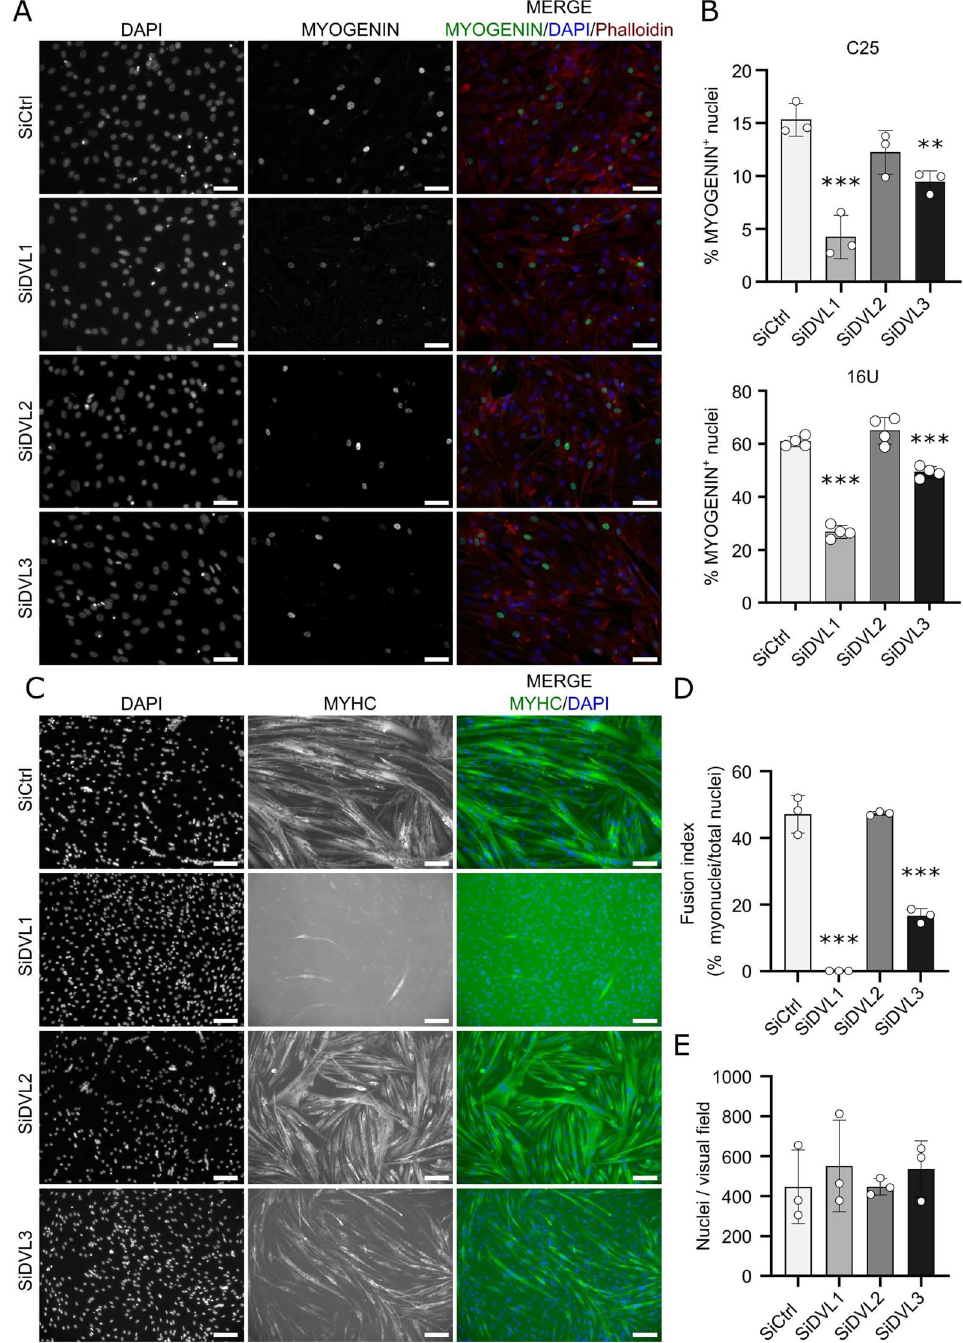
Figure 3. Knockdown of DVL1 or DVL3 retards myogenic differentiation in human myoblasts. ( A ) Differentiation was induced 48 h after DVL knockdown, and cells were fixed after 24 (C25) or 48 h of differentiation (16U). Representative images of differentiating C25 myocytes after knockdown of each DVL isoform, immunolabelled for MYOGENIN (green), with F-ACTIN (phalloidin, red) and nuclear counterstain DAPI (blue). Scale bars represents 50 µm. ( B ) Quantification of nuclei containing MYOGENIN in human C25 or 16U myocytes after knockdown of each DVL isoform. More than 200 nuclei were analysed for each N = 3–4 biological replicates. Data is represented as mean ± SD with significant differences calculated using a One-Way ANOVA with Dunett’s post-hoc test, comparing each group with the control (SiCtrl), where two asterisks indicate p < 0.01 and 3 asterisks p < 0.001. ( C ) Representative images of differentiating C25 myotubes after knockdown of each DVL isoform, immunolabelled for MYHC (green), with nuclei counterstained with DAPI (blue). Scale bar represents 100 µm. ( D ) Quantification of Fusion Index (myonuclei in myotubes with 2 or more nuclei/total nuclei) for C25 myotubes after knockdown of each DVL isoform, N = 3 biological replicates. ( E ) Number of nuclei per field in C25 myotubes after knockdown of each DVL isoform, N = 3 biological replicates. Data is represented as mean ± SD with significant differences calculated using a One-Way ANOVA with Dunett’s post-hoc test, comparing each group with the control (SiCtrl), where three asterisks indicate p <